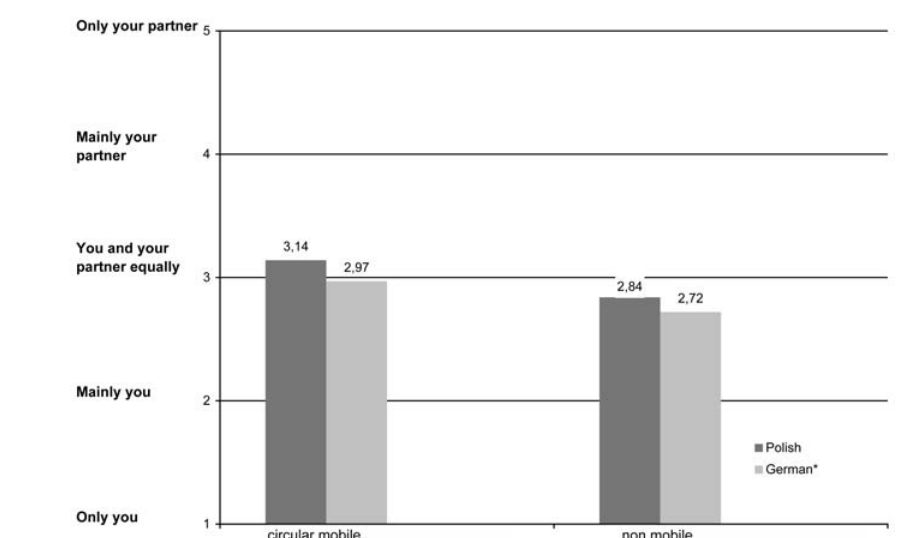
Figure 2: “Who of you spends time in handling housework?” by nation and mobility